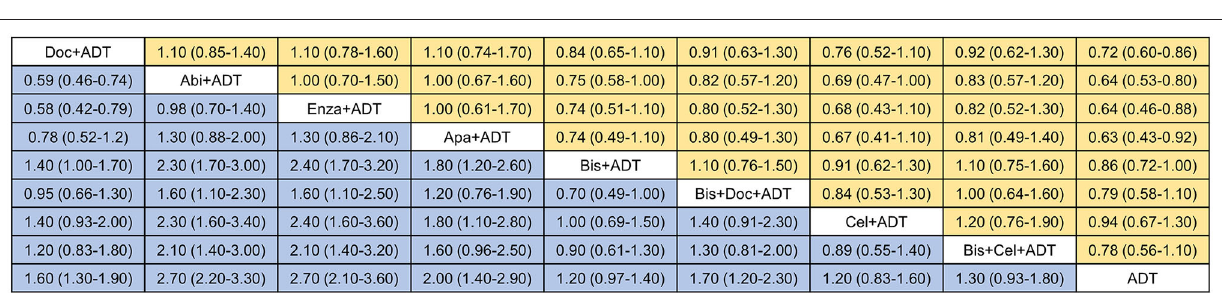
FIGURE 3 | Network comparisons of effect of systemic therapies on overall survival (yellow) and failure-free survival (blue). Results are the HRs with 95% CrIs from the network meta-analysis between the row intervention and column intervention. Doc, docetaxel; Abi, abiraterone; Enza, enzalutamide; Apa, apalutamide; Bis, bisphosphonate; Cel, celecoxib; ADT, androgen-deprivation therapy.